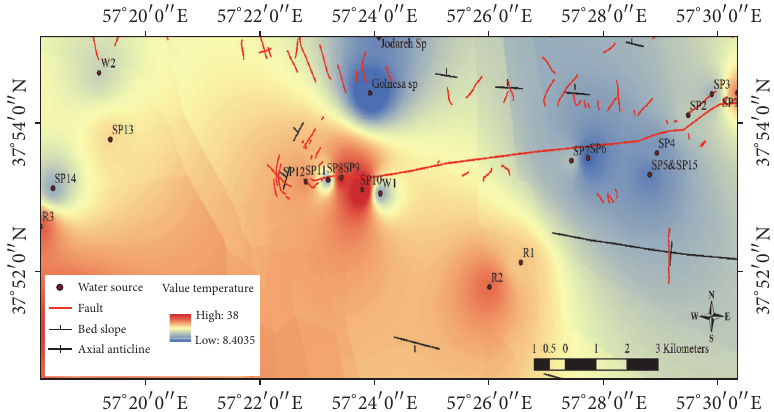
Figure 6: The thermal anomalies map of the study